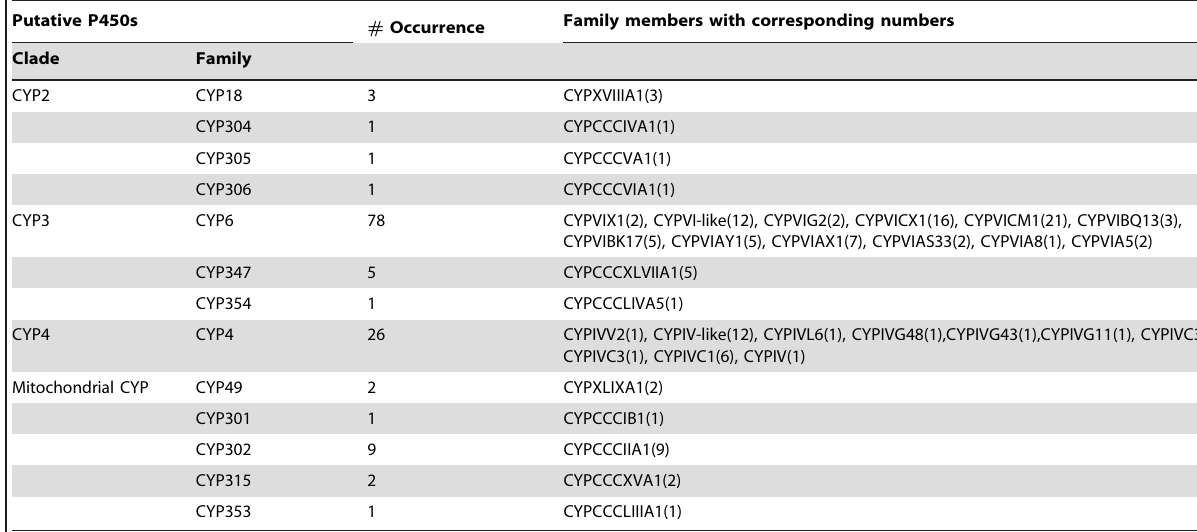
Putative P450s # Occurrence Family members with corresponding